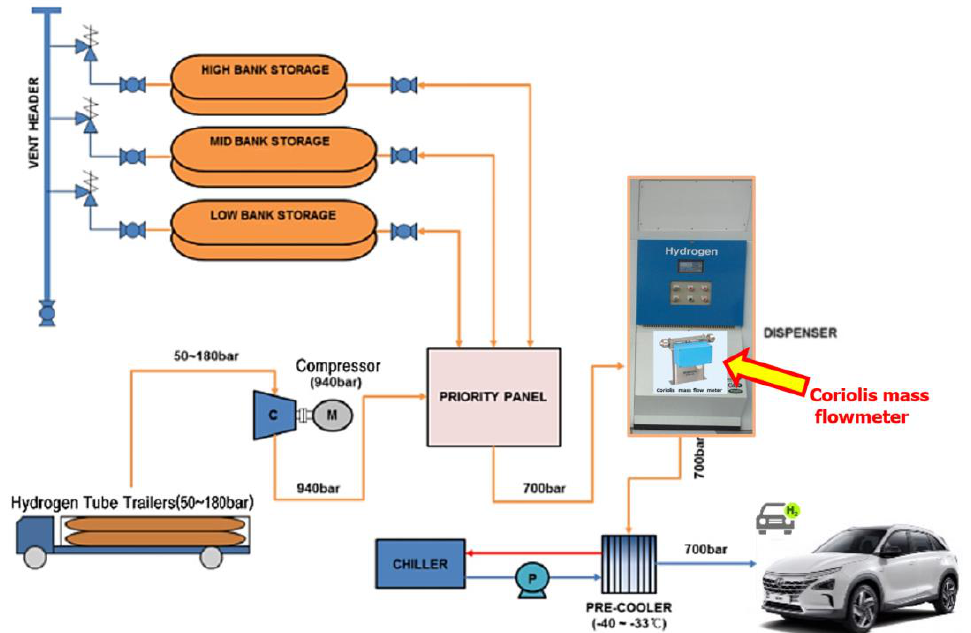
Figure 1. Sample layout for a hydrogen refueling station and the Coriolis mass flowmeter in the dispenser.